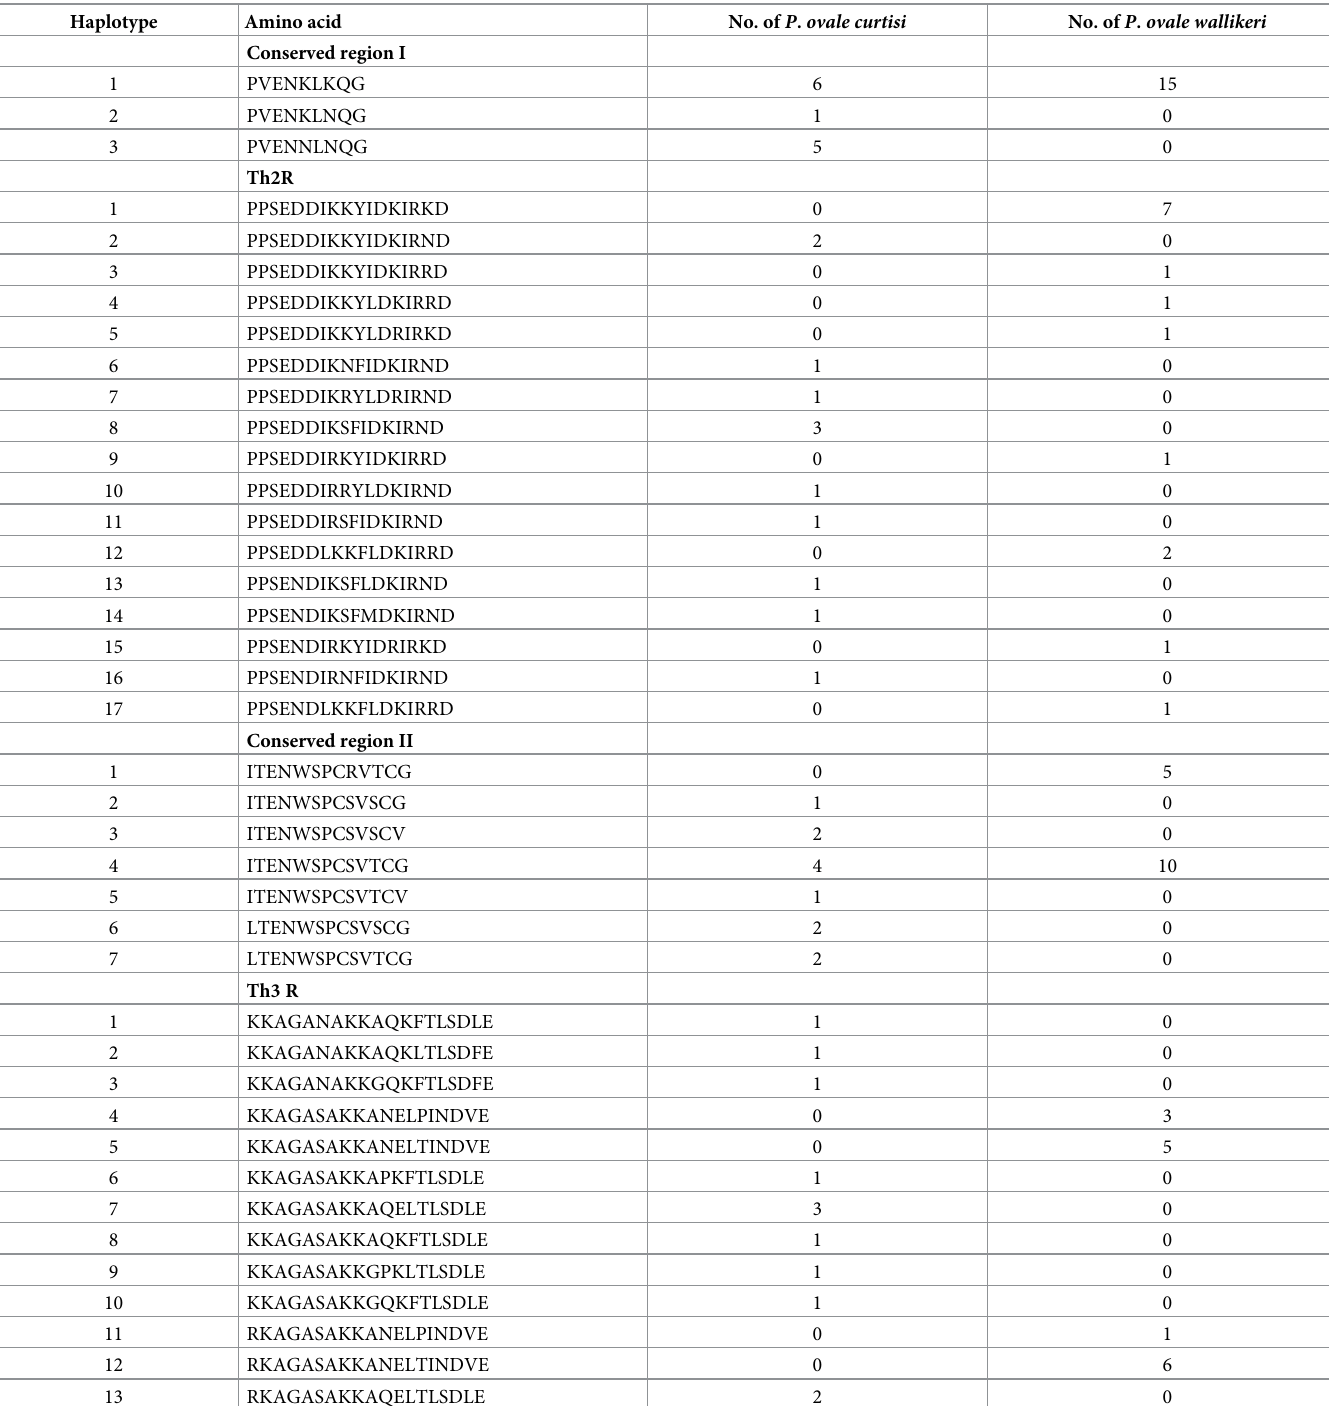
Table 3. Sequence polymorphism in the conserved regions of P . ovale